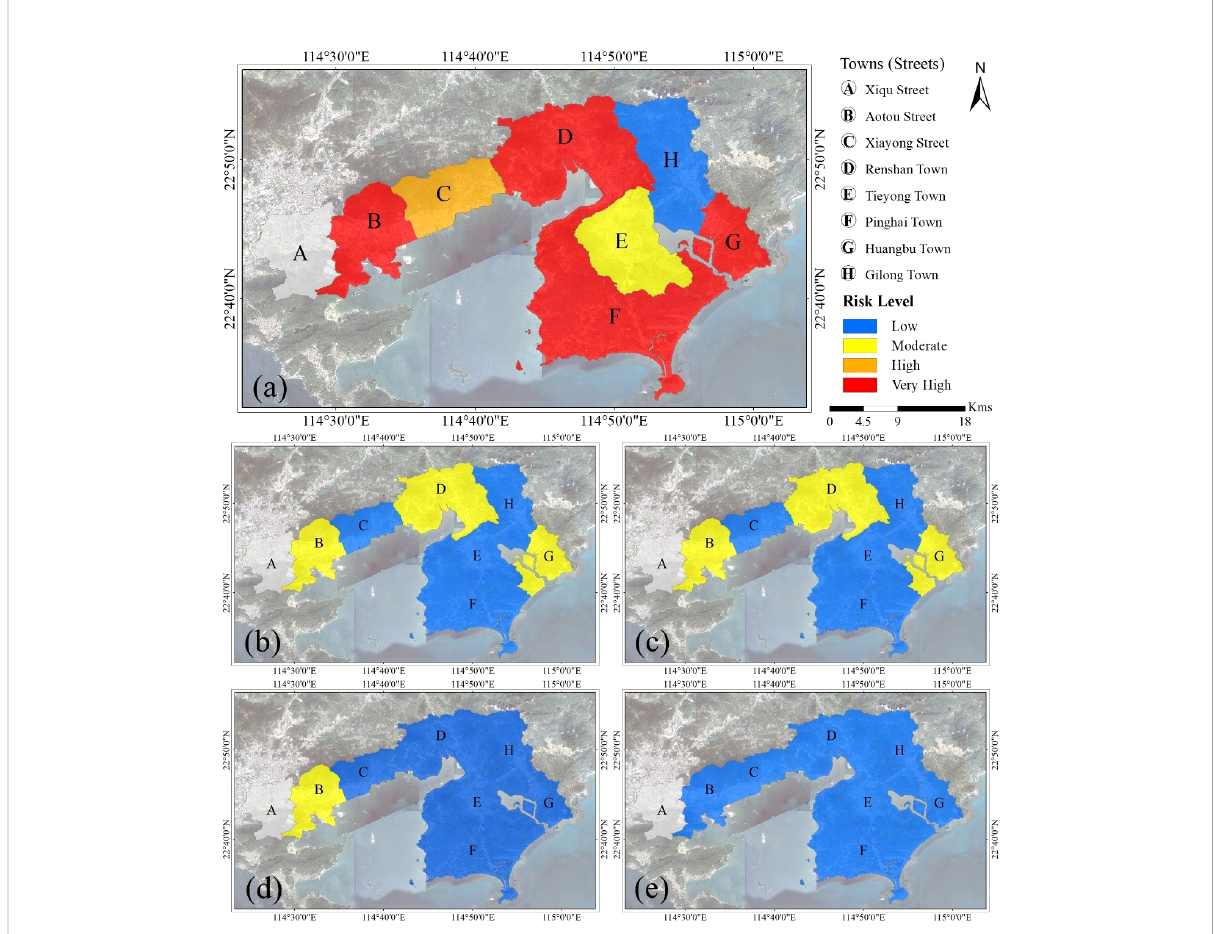
FIGURE 13 The risk zonation maps based on quantitative risk assessment of storm surge under different typhoon scenarios (1000-year (A) , 100-year (B) ,50- year (C) , 20-year (D) and 10-year (E) return